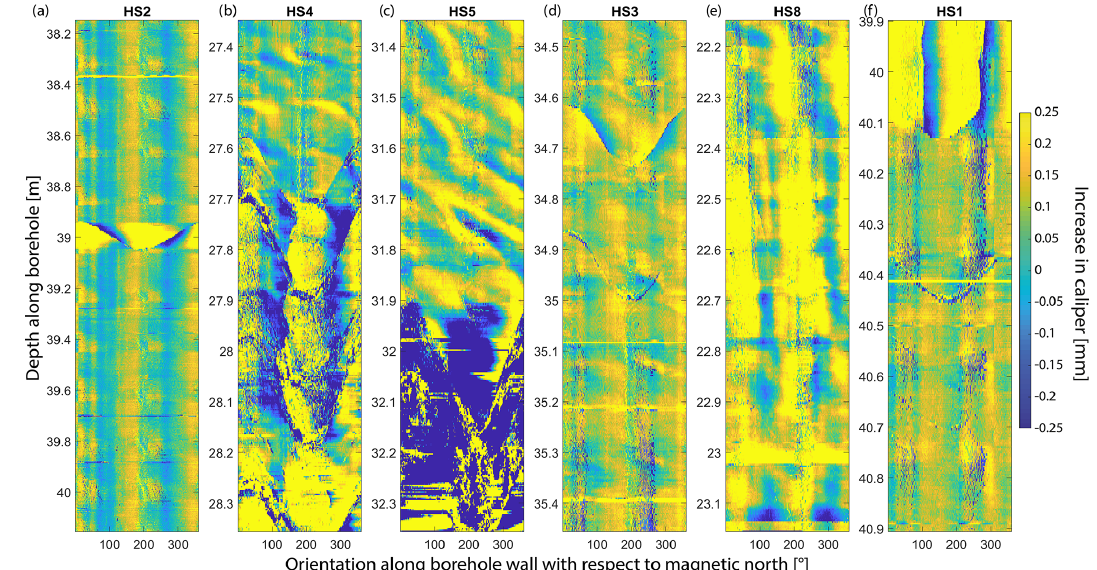
Figure A4. Difference plots from ATV logs. Logs are in chronological